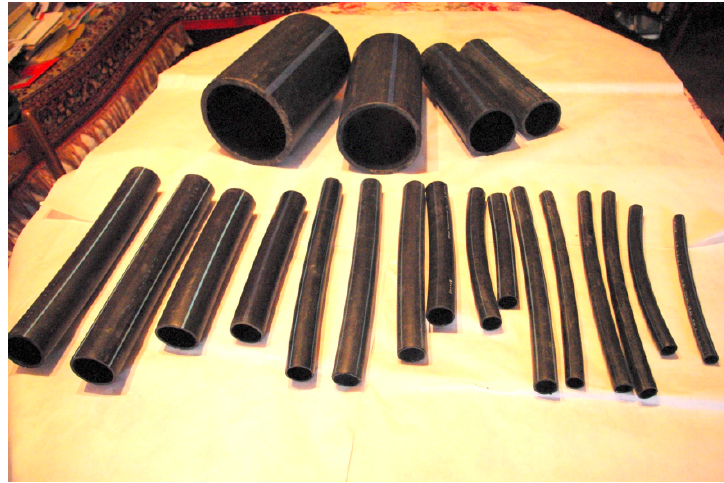
Figure 2. Pipes of different sizes used in water supply networks (for connections, arteries and distribution).